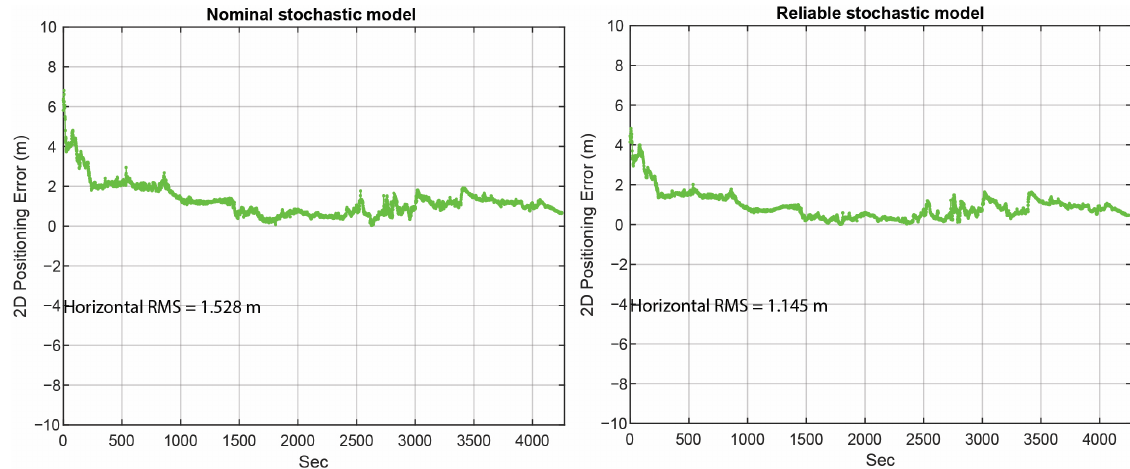
Figure 10. Horizontal positioning error in two cases: ( left ) nominal stochastic model and ( right ) reliable stochastic model.